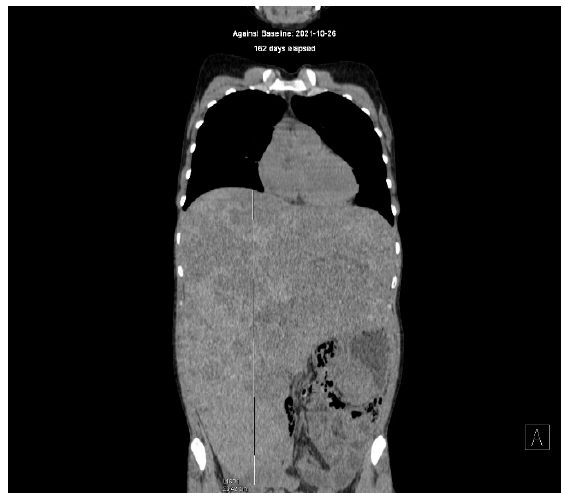
Figure 1. Advanced wild-type GIST originating in the stomach in young adult women treated for 18 years. 18